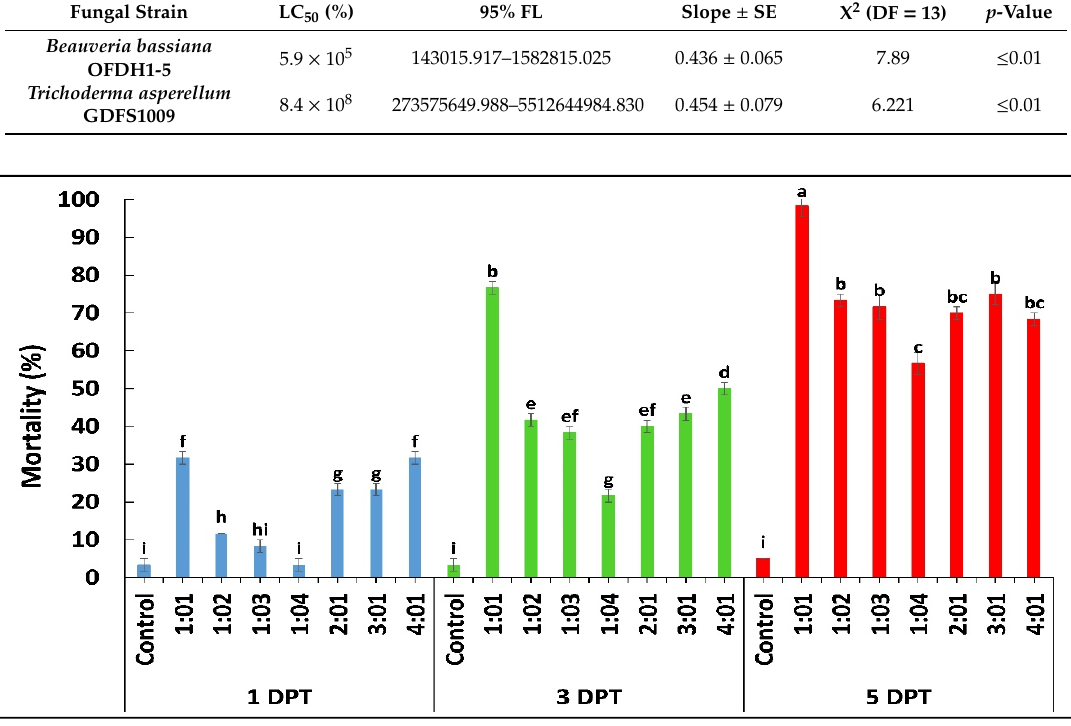
Figure 2. Mortality (%) of O. furnacalis larvae fed on diet incorporated with binary combination of B. bassiana OFDH1-5 + T. asperellum GDFS1009 in different proportions recorded at 1, 3, and 5 days post treatment (DPT). Means followed by different lowercase letters above each bar indicates significant differences among the treatments (p < 0.05).